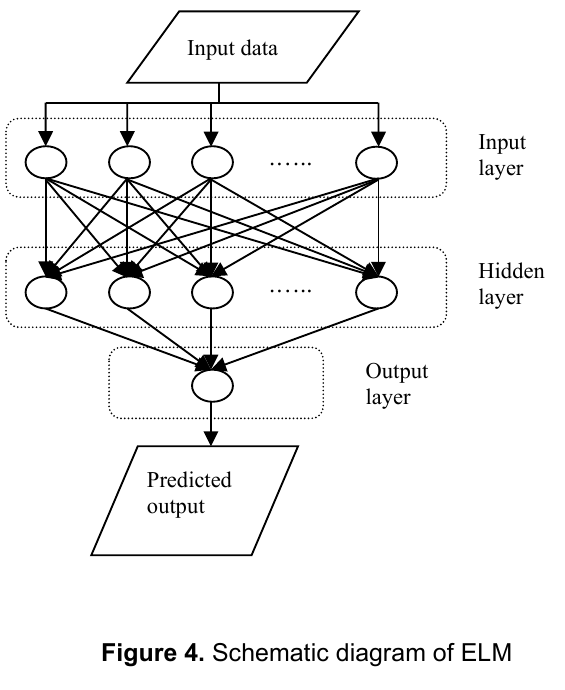
Figure 4. Schematic diagram of ELM